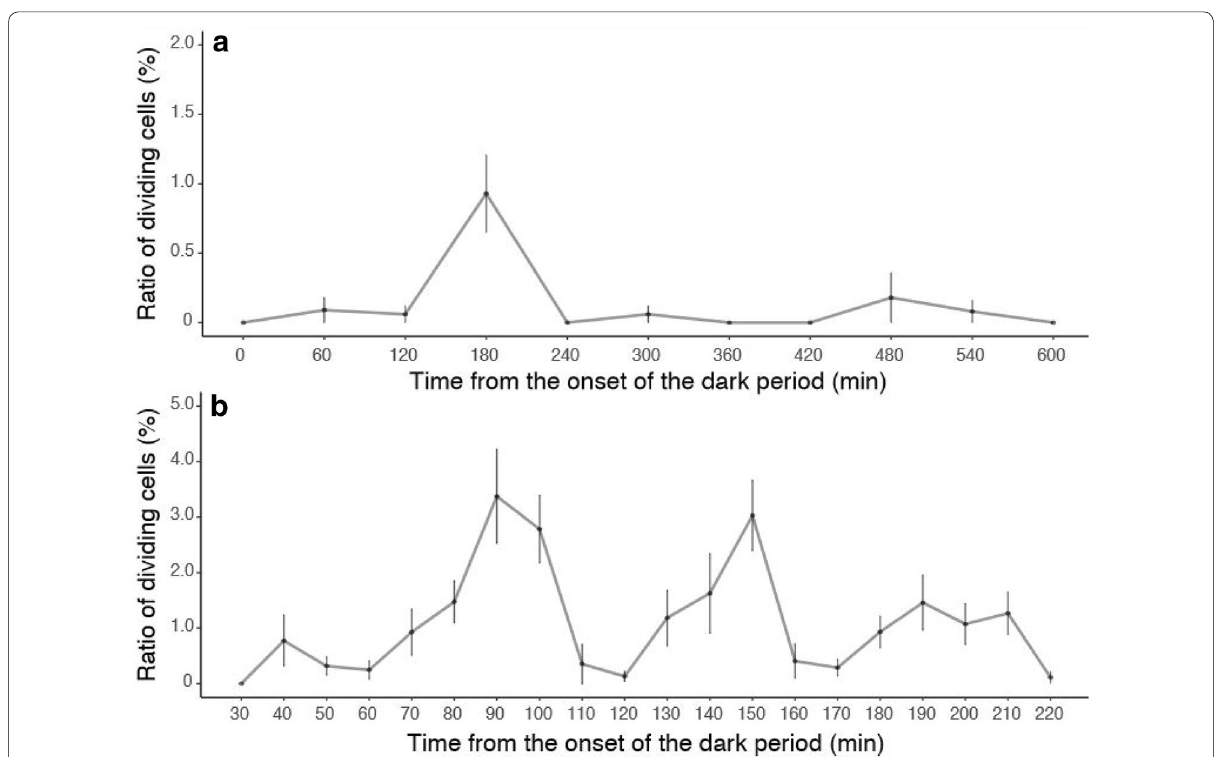
Fig. 1 Ratio of dividing cells in gametophytes (mean and 95% confidence interval) after the onset of the dark period. a Ratio of dividing cells during the dark period examined every 60 min. b Ratio of dividing cells within 220 min from the onset of the dark period examined every 10 min